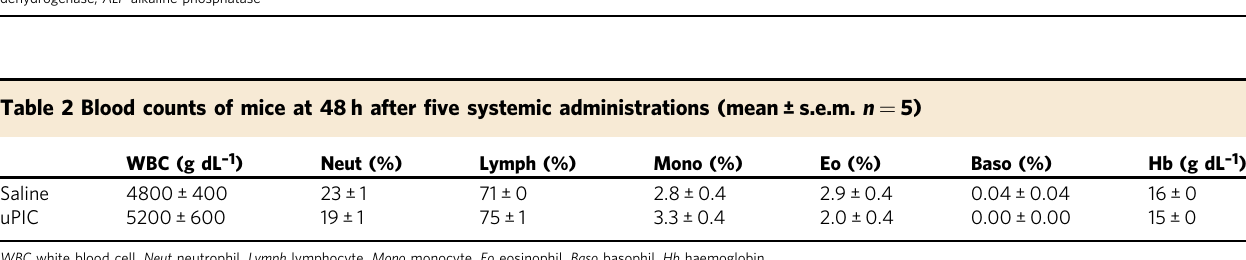
Fig. 4 Gene silencing and therapeutic effects of uPIC. a PLK1 mRNA level in tumour tissues harvested from subcutaneous BxPC3 tumour-bearing mice intravenously injected twice with uPIC at 24-h intervals. Data represent the means ± s.e.m. n = 5 for siLuc/uPIC and 10 for sihPLK1/uPIC. b , c PLK1 protein level in the tumour tissues harvested from subcutaneous BxPC3 tumour-bearing mice intravenously injected with PBS, uPIC, Invivofectamine ® LNP, and naked sihPLK1 thrice at 24-h intervals, as determined by western blotting ( b ), and the quanti fi ed results ( c ). Data represent the means ± s.d. n = 3. d – h Apoptosis in subcutaneous BxPC3 tumour tissues from mice treated with sihPLK1/uPIC ( d ), siLuc/uPIC ( e ), naked sihPLK1 ( f ), or PBS ( g ) based on a TUNEL assay (red: apoptosis-positive cells; blue: cell nuclei stained with Hoechst 33342; scale bar: 100 µ m), and the quanti fi ed results ( h ). Data represent the means ± s.e.m. n = 4. i Antitumour activity of uPIC intravenously administered multiple times (as shown by black arrows) to BxPC3 tumour-bearing mice. Data represent the means ± s.e.m. n = 7. j Body weight change in tumour-bearing mice treated with uPIC as described in ( i ). Data represent the means ± s.e.m. n = 7. k RNAi effect of uPIC in a spontaneous pancreatic tumour model. The luminescence intensity from luciferase-expressing pancreatic